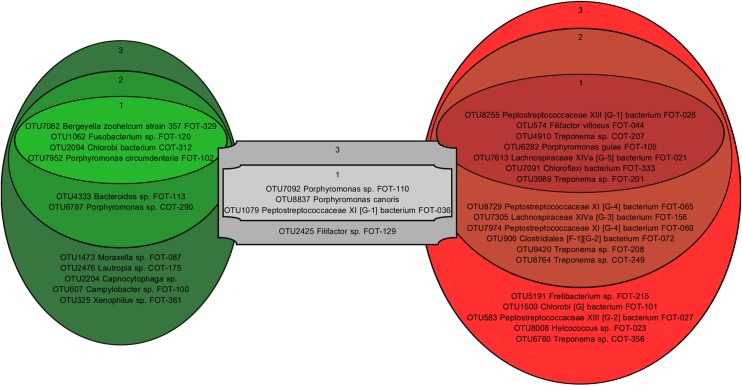
The feline construal of the core microbiota in health and mild periodontitis figure from Abusleme et al. (2013).OTUs were defined as part of the core microbiota if they represented ≥0.5% of sequence reads in at least 50% of samples. If they were equally prevalent and abundant in healthy and mild periodontitis samples they formed part of the core microbiota (grey rectangles). If they were more prevalent and abundant in healthy samples they formed part of the healthy core (green ovals). If they were more prevalent and abundant in mild periodontitis samples they formed part of the mild periodontitis core microbiota (red ovals). Relative prevalence and abundance data were used for further sub-division. Ovals labelled with 1 contain highly prevalent (≥2/3rd of samples) and highly abundant OTUs (≥2% of sequences). Ovals labelled with 2 contain highly prevalent (≥2/3rd of samples) with lower abundances (<2% of sequences). Ovals labelled with 3 contain less but still highly prevalent OTUs (≥1/2 and <2/3rd of samples).